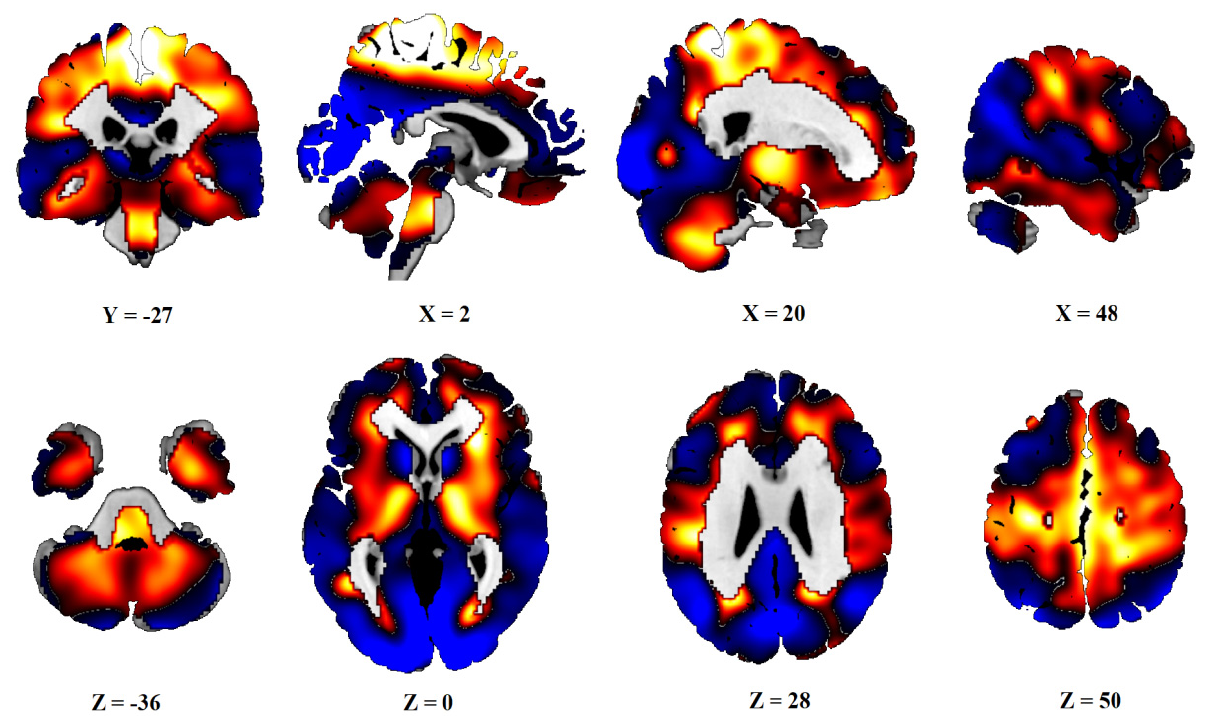
Figure 1. Topography of PDRP. Distribution of positive (red) and negative (blue) voxels of PDRP. Voxel values PDRP are overlaid on a T1 MRI template. Coordinates in the frontal (Y), sagittal (X) and axial (Z) planes are in Montreal Neurological Institute (MNI) standard space. The left side is on the left.